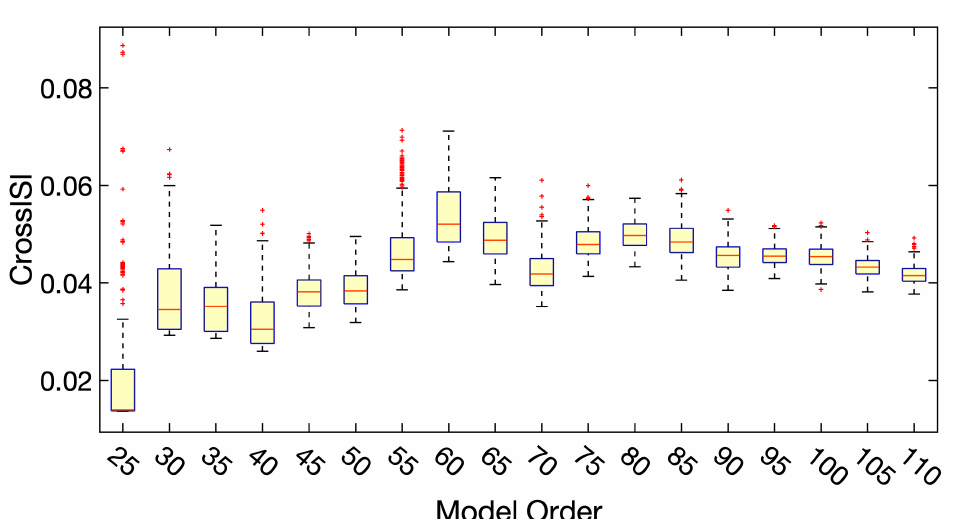
Figure 2. Using Cross-ISI as an objective index of choosing an appropriate model order of group ICA-EBM. The estimated model orders ranging from 25 to 110 with step size 5 and 300 runs of ICA-EBM with random initialization are applied to each one of the estimated model orders. The final model order is decided by considering various factors, including the lowest Cross-ISI value, the variance of the Cross-ISI, and the anatomical and functional properties of each model order result. For each box, the lines from top to bottom represent the maxim, the 25th and 75th percentiles, the median, and the minimum of the Cross-ISI, respectively. The red plus signs represent outliers.